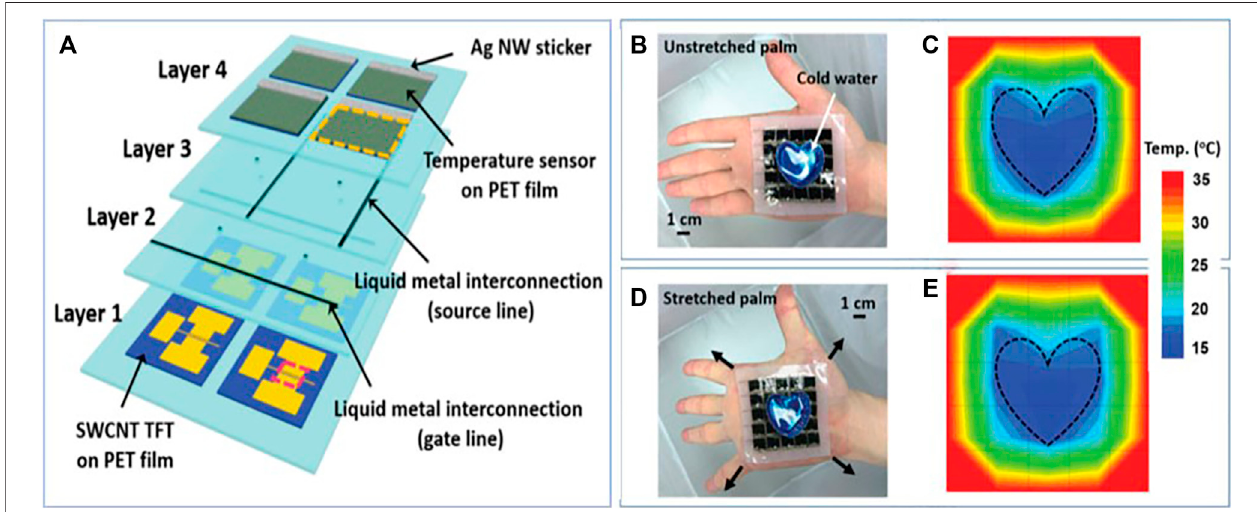
FIGURE 4 | (A) The fl at palm attached the encapsulated fl exible temperature sensor array with a heart-shaped aluminum container, and the cold water (15 ° C) is fi lledinthecontainer. (B) Distributionofmeasuredtemperatureofthe fl atpalmby fl exibletemperaturesensorarray. (C) Theunstretchedpalmattachedtheencapsulated fl exibletemperaturesensorarraywithaheart-shapedaluminumcontainer,andthecoldwater(15 ° C)is fi lledinthecontainer. (D) Distributionofmeasuredtemperatureof the stretched palm by fl exible temperature sensor array. (E) The stretched palm attached the encapsulated fl exible temperature sensor array with a heart-shaped aluminum container, and the cold water (15 ° C) is fi lled in the container. (Hong et al., 2016).